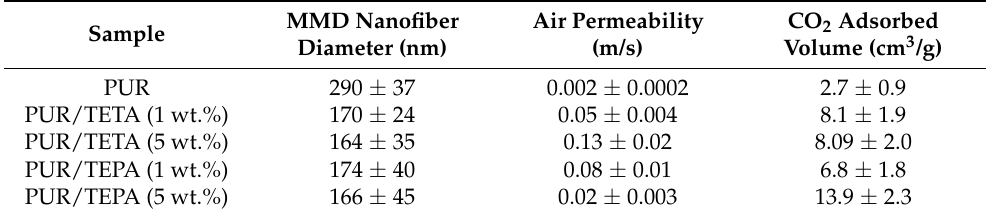
Figure 2. HRSEM images ( a ) pristine PUR without the occurrence of glued parallel fiber bundles or fused bands and layers; ( b ) PUR/TEPA (1 wt.%). A distinct characteristic feature of this sample is parallel bundles of fibers alternating with an irregular network; ( c ) PUR/TEPA (5 wt.%). After in- creasing the TEPA concentration to 5 wt.%, the individual fibers were fused into continuous strips and layers. 3.2. XRD Analysis The XRD structure analysis confirmed the crystallization of PUR during the spinning process (Figure 3). The diffraction profile at 2 θ ~20° corresponds to the parallel arrangements of the PUR chains in the fiber axis. This position of the main peak for PUR Larithane is shifted to a lower angle in comparison with the XRD profiles for electrospun polyamide 6 [49,51] and polyvinylidene fluoride [50], indicating the higher space requirement for PUR Larithane chains due to their larger volume (isophorone diisocyanate and one hexane-1,6- diol). Electrospun membrane samples are always strongly textured, which means that the diffraction profiles corresponding to the crystallographic planes perpendicular to the fiber axis are missing. In addition, the large width of the diffraction profiles shows very small PUR crystallites, which means no observable reflections were present at high 2 θ angles. The